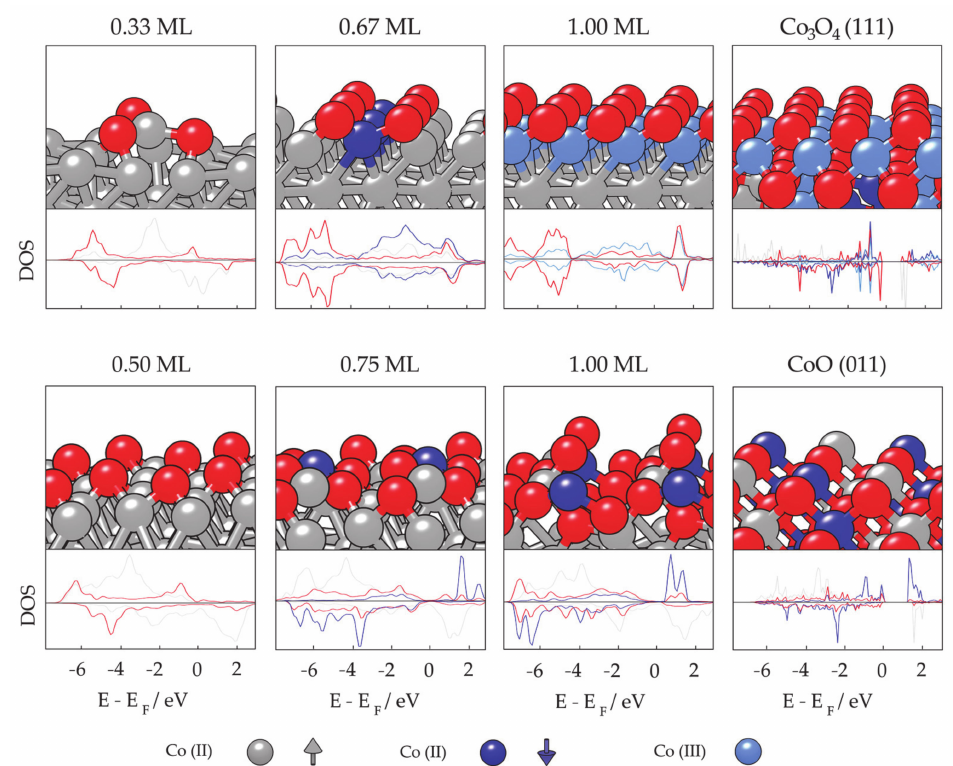
Figure 8. Optimised magnetic orderings for different oxygen coverages on hcp Co ( 0001 ) ( top panel ) (cid:0) (cid:1) and 1011 surface ( bottom panel ) as computed by GGA + U; orderings of predicted directions of cobalt oxide growth are provided on the right. Below structures, pDOS in a.u. (range − 2.5 to 2.5 states/eV) for 3 d orbitals of each distinguishable Co surface atom and 2 p orbitals of O atoms. Grey, dark blue, and light blue spheres represent Co (II) up spin, Co (II) down spin, and Co (III) atoms, respectively, with oxygen shown as red